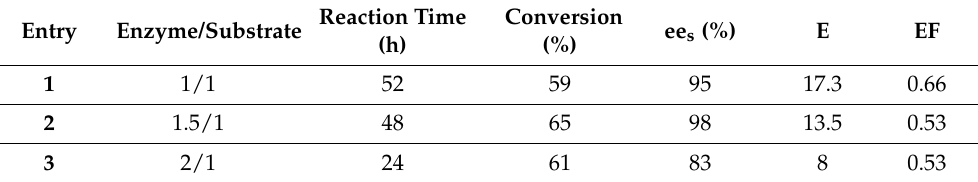
Table 5. Effect of the enzyme/substrate ratio on the kinetic resolution of rac -ibuprofen in isooc-